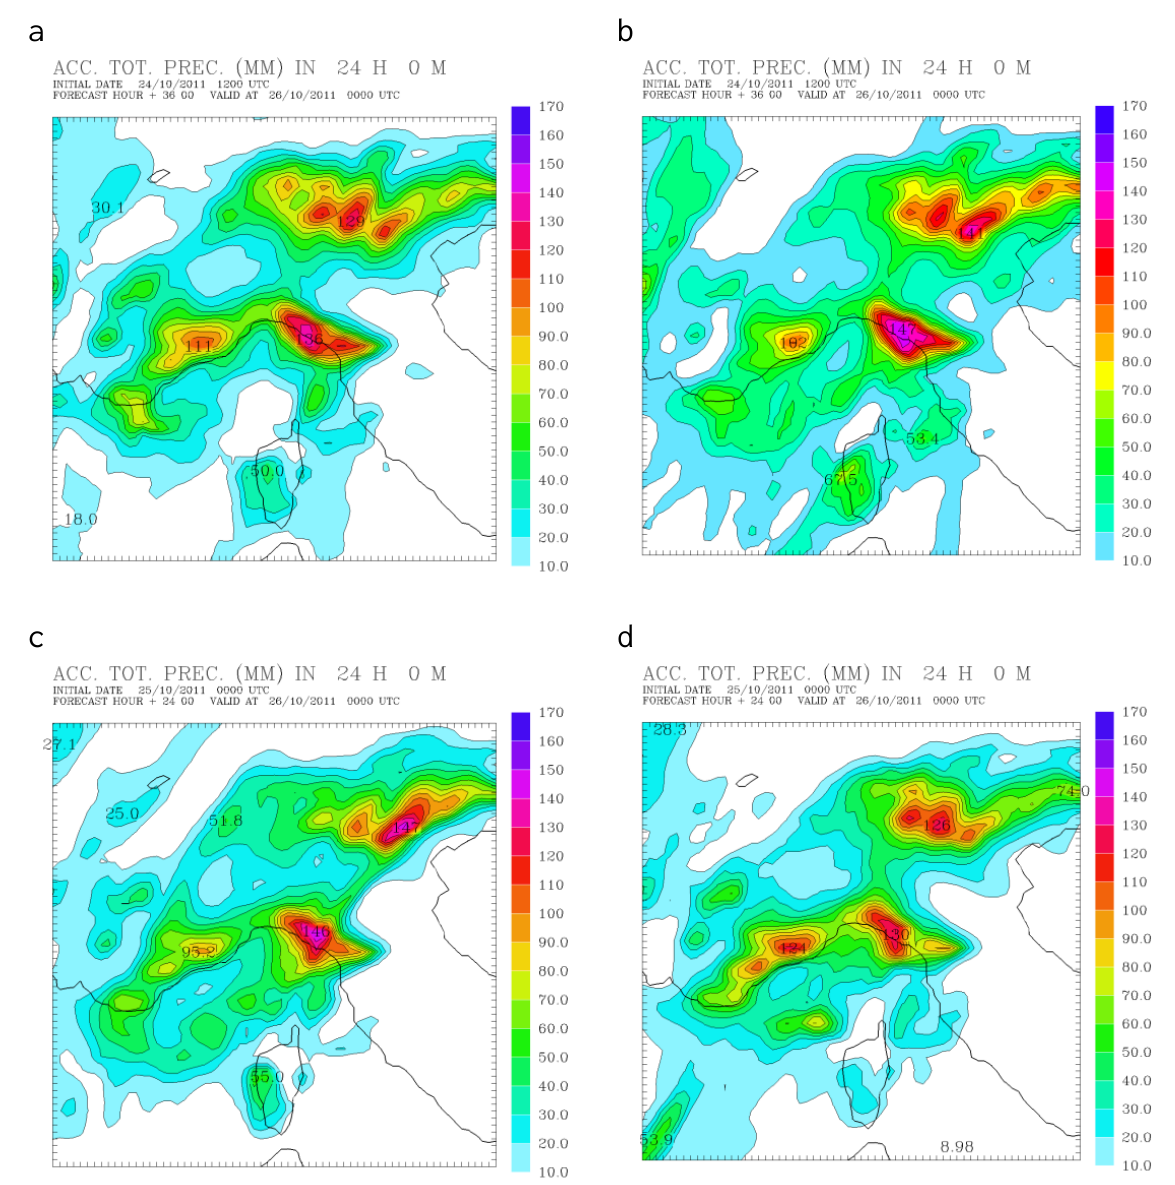
Figure 5. Precipitation accumulated in the 24h period starting at 00:00UTC of 25 October 2011 in BOLAM forecast runs based on ECMWF- IFS (left column) and NOAA_GFS (right column) analyses. Upper panels: analyses of 12:00UTC of 24 October; lower panels: analyses of 00:00UTC of 25